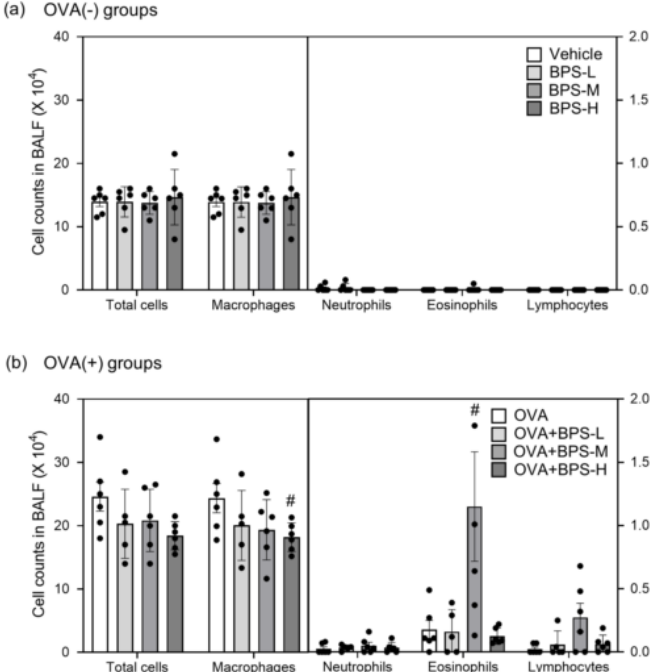
Figure 2. Cellular profile in BAL fluid. ( a ) Vehicle-administered groups. ( b ) OVA-administered groups. Data are expressed as mean ± SE for 5–6 animals per group. # p < 0.05 vs. OVA group. BAL, bronchoalveolar lavage; OVA, ovalbumin; SE, standard error.